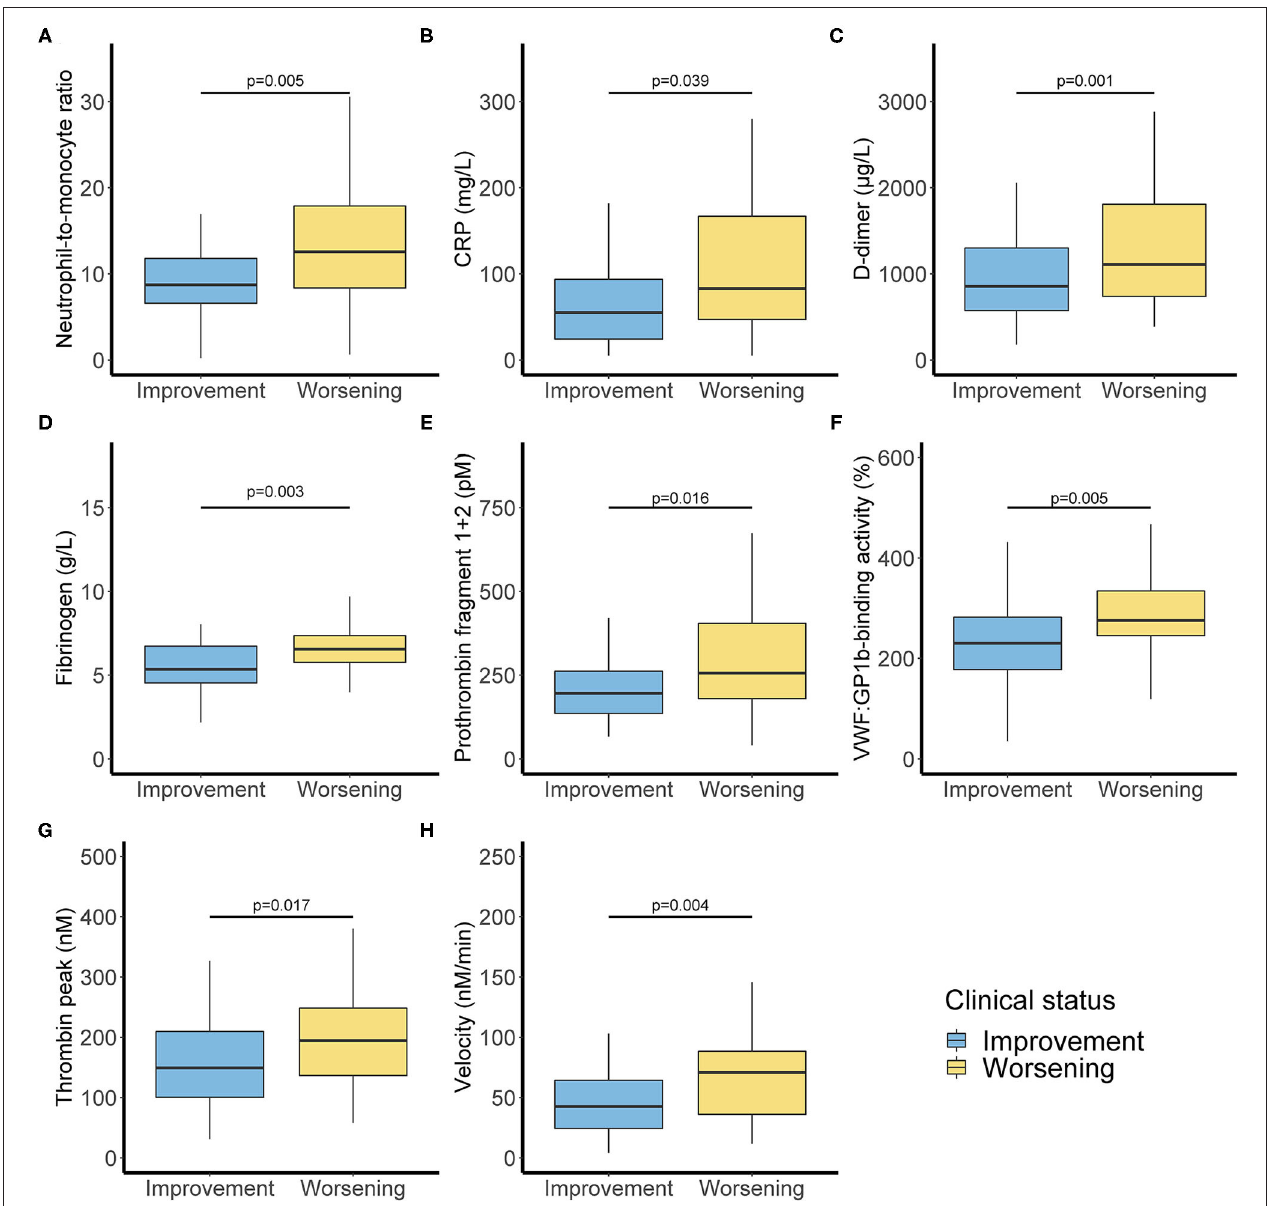
FIGURE 1 | Inflammatory and coagulation biomarkers associated with clinical worsening. Inflammation markers with neutrophil monocyte ratio (A) and C-reactive protein (B) . Activated coagulation with D-dimer (C) , fibrinogen (D) , and Prothrombin fragment 1 + 2 (E) . Increased Von Willebrand factor activity (F) and thrombin generation with thrombin peak (G) and velocity (H) . P -values comparing clinical improvement to clinical worsening are from Mann–Whitney U